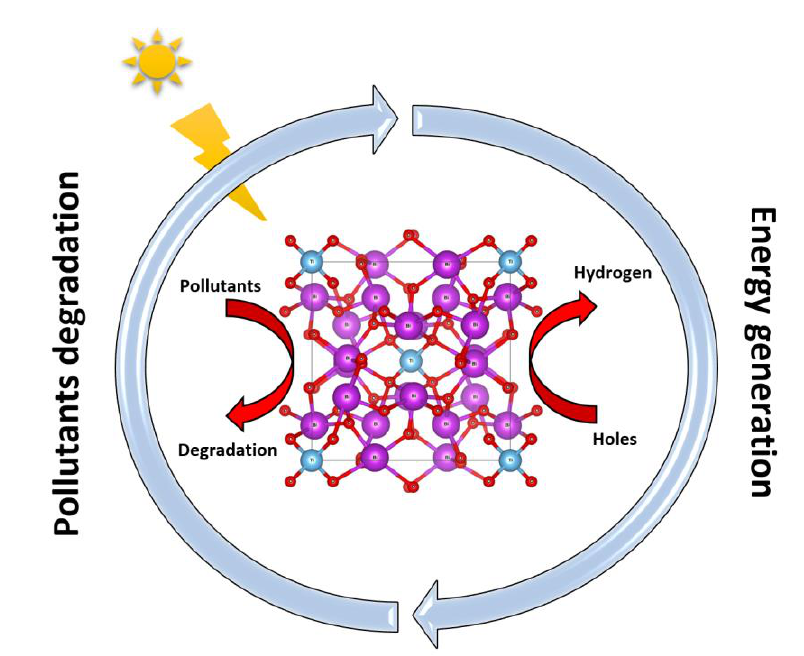
Figure 2. Sillenites for environmental applications: Pollutants degradation and energy generation.